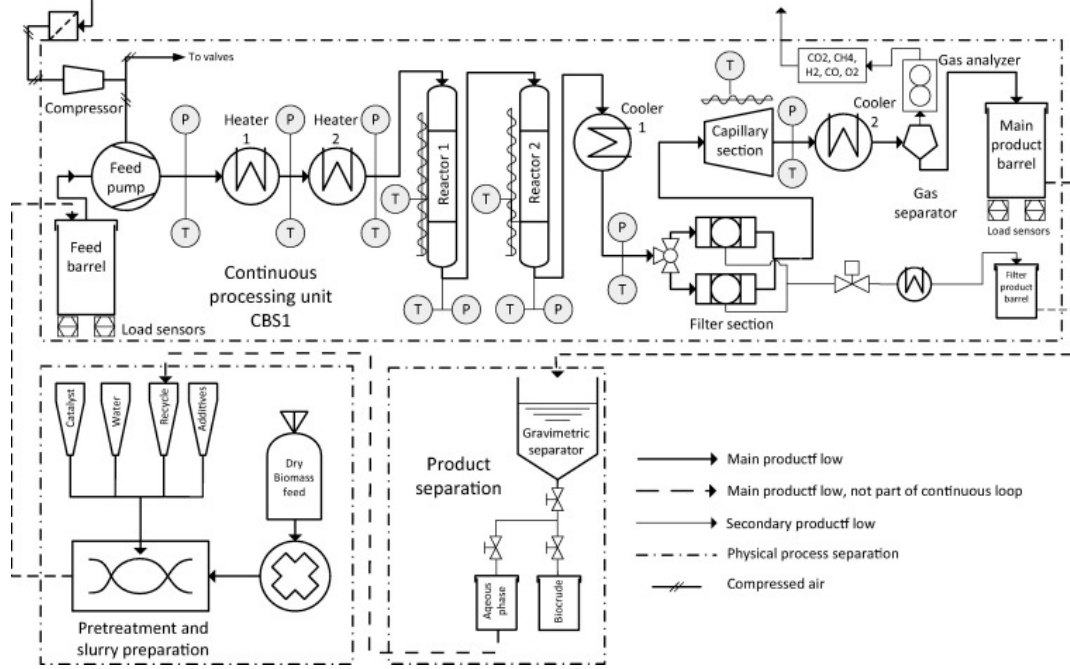
Figure 5. Process scheme of the Continuous Bench-Scale (CBS1) plant built at Aalborg University, Denmark. Reproduced from [27], with permission from Elsevier, © Elsevier 2015.